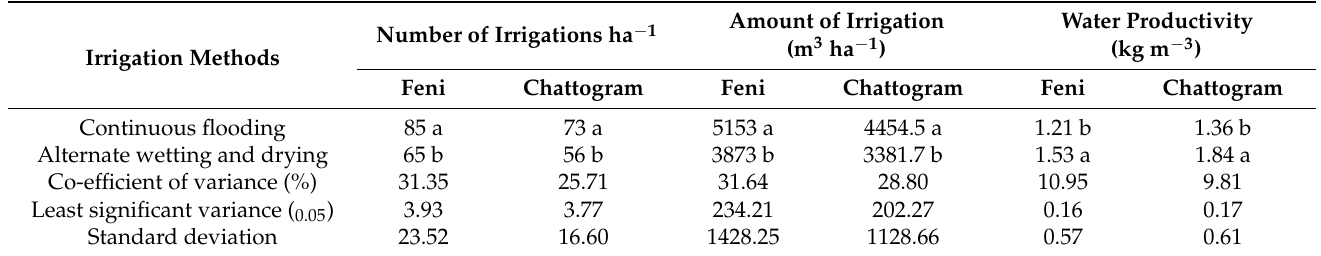
Table 2. Effect of irrigation methods on the water requirement and water productivity of paddy field in the Feni and Chattogram